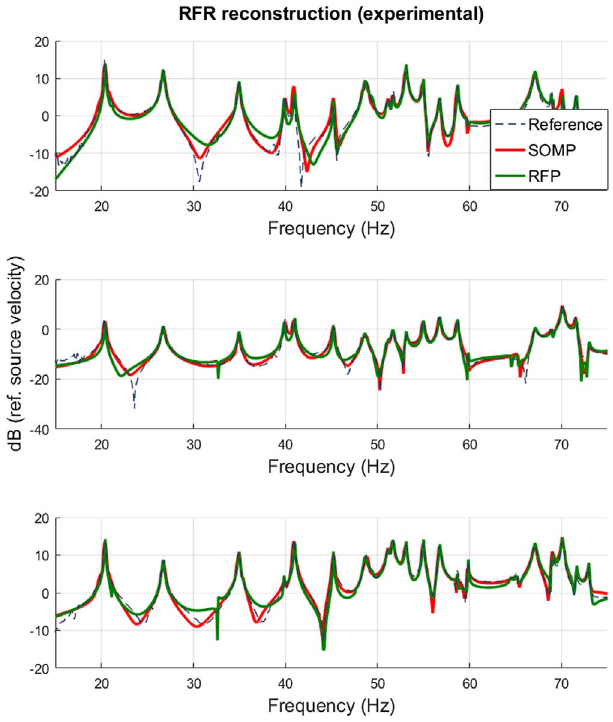
Figure 12. RFR reconstruction from 25 measurements for three different evaluation points in the room using RFP and SOMP (correlation ranging between 97% and